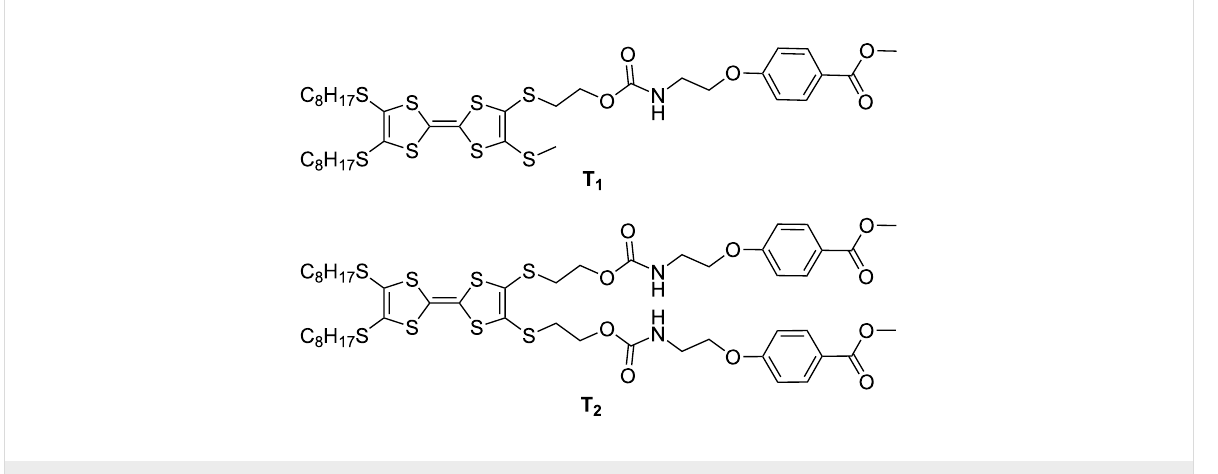
Figure 1: Molecular structure of TTF derivatives T 1 and T 2